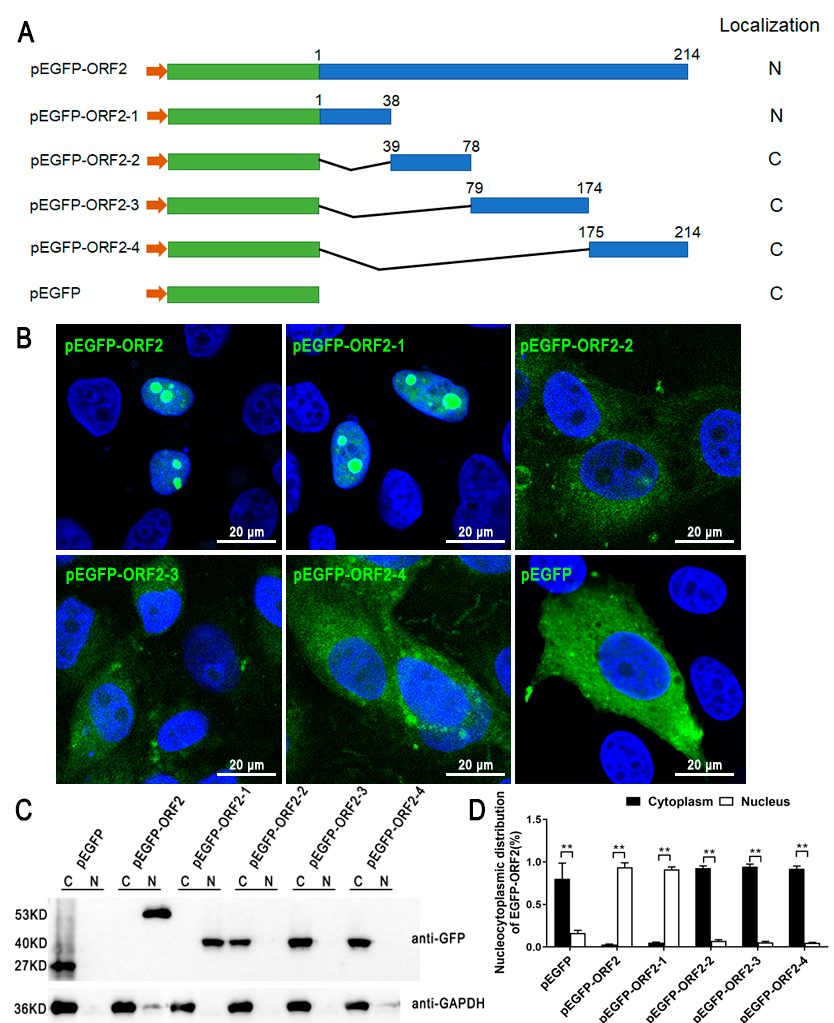
Figure 1. The localization of nuclear localization signals (NLSs) in ORF2. ( A ) Recombinant plasmids containing ORF2 or truncated ORF2 fragments with EGFP in the N-terminus were constructed. The subcellular localization of fusion proteins is indicated by N (nuclear) or C (cytoplasmic). ( B ) The localization of fusion proteins in transfected cells was observed by confocal microscopy. Scale bars = 20 µ m. ( C ) and ( D ) Transfected cells were subjected to nuclear and cytoplasmic extraction. The abundance of expressed proteins in the nuclear and cytoplasmic extracts were detected by western blot. Nuclear / cytoplasmic distribution of the expressed proteins was further analyzed through densitometric quantification using Image-Pro software, data from three independent experiments are shown on the graph as the average ± standard error. One-way ANOVA; ** p <